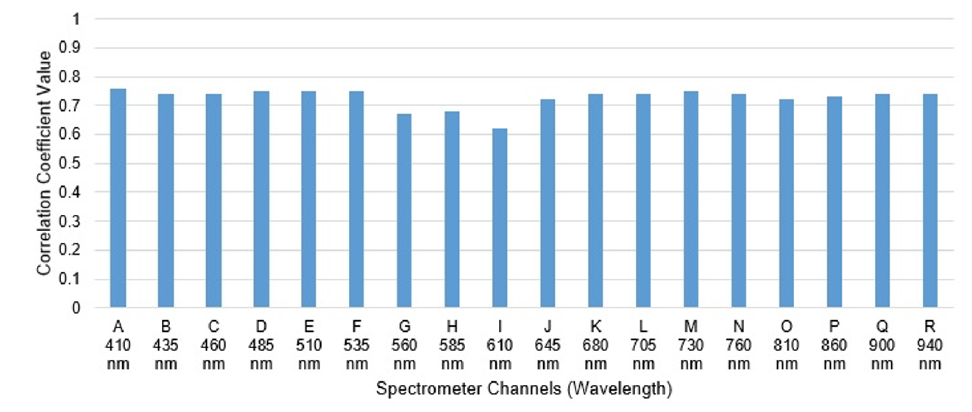
Figure 10. Aerial spectrometer channels’ correlation coefficients with corresponding ground- based channels.